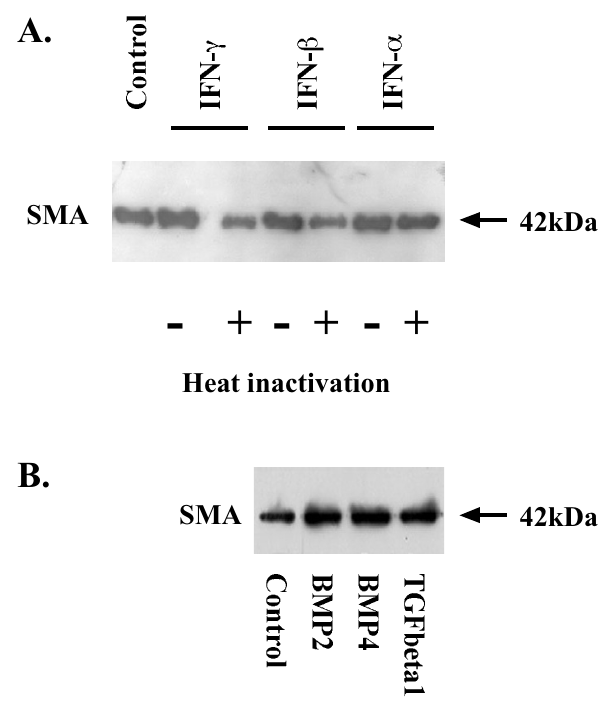
Figure 6 Effect of interferons, transforming growth factor beta1, bone morphogenetic protein 2 and bone morphogenetic protein 4 on SMA abundance in rat HSCs. Sub-cultured HSCs were incubated with water only, 500 U/ml of different IFNs for 6 days and the abundance of SMA in HSCs was documented in panel A, while sub-cultured HSCs were treated with 5 ng/ml of transforming growth factor beta1, 5 ng/ml of bone mor- phogenetic protein 2 and 5 ng/ml of bone morphogenetic protein 4 for 4 days and the abundance of SMA in HSCs was presented in panel B. HI indicates